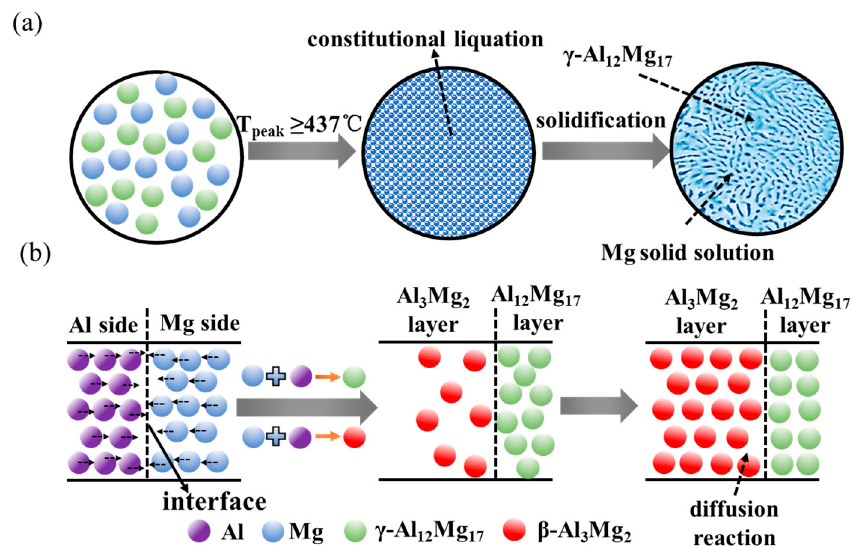
Figure 10. Schematic illustration of the formation of constitutional liquation and reaction diffusion at different position during Al/Mg dissimilar FSW. ( a ) Constitutional liquation at the top of Mg side interface; ( b ) reaction diffusion at the lower-middle and bottom of Mg side interface